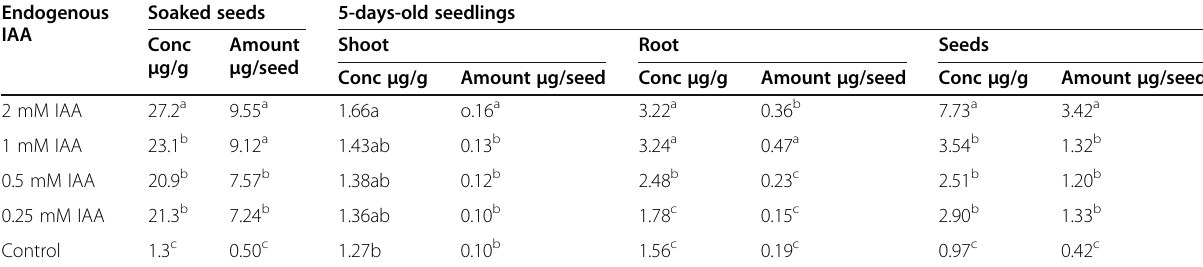
Table 2 Effect of pre-soaking maize seeds in IAA for 48 hours on concentration and distribution of endogenous IAA in soaked seeds and 5-days-old seedlings